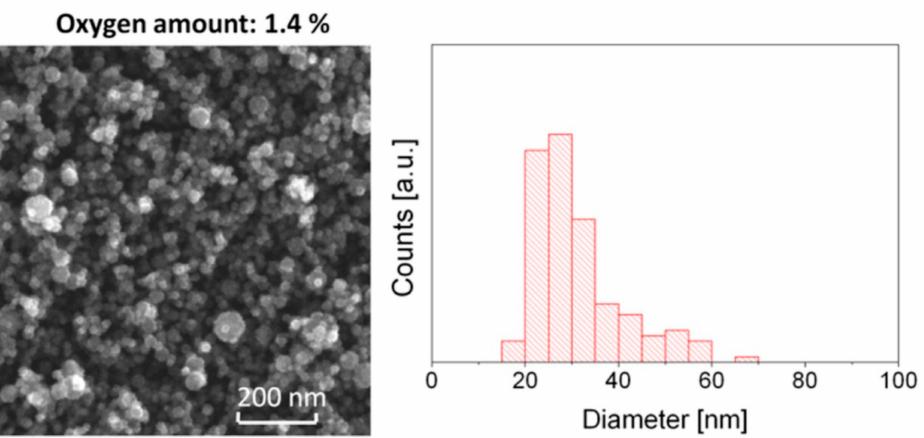
Figure 2. SEM images and corresponding size histograms of TiO 2 nanoparticles (NPs) deposited using Ar / O 2 mixture with 1.4% of O 2 . Adapted with permission from [37]. Copyright (2012)